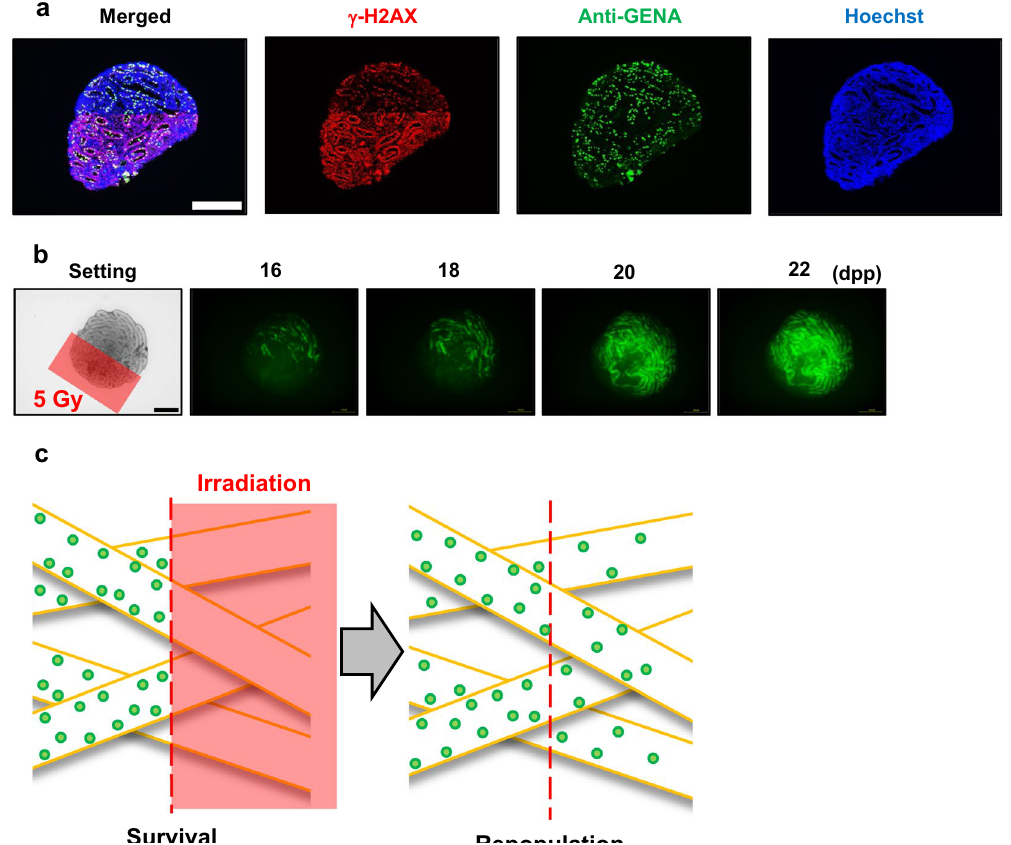
Figure 5. Chronological GFP expression changes after X-ray half-irradiation. ( a ) Immunohistochemical images of ex vivo testis tissues 1 h after 10 Gy X-ray 50% irradiation using X-ray microbeams. Staining for γ -H2AX, Anti-GENA and Hoechst is shown as red, green and blue, respectively. Scale bars, 500 μ m. ( b ) Representative images showing Acr-GFP expression in single cultures of testes exposed to 5 Gy 50% irradiated X-ray microbeams obtained at 16, 18, 20 and 22 dpp. In the irradiation setting image, the irradiated area is shown as a red square. The Acr-GFP expression areas expanded from the non-irradiated to the irradiated areas due to the tissue-sparing effect. Scale bars, 500 μ m. ( c ) Schematic representation of the two-step process of the tissue-sparing effect in spermatogenesis. First, spermatogonial cells survive in the non-irradiated areas, whereas they are eliminated in the irradiated areas after irradiation. The surviving cells then migrate to the irradiated area via the seminiferous tubules. Thus, the spermatogonial cells require these two steps, survival and migration, for an effective tissue-sparing effect in